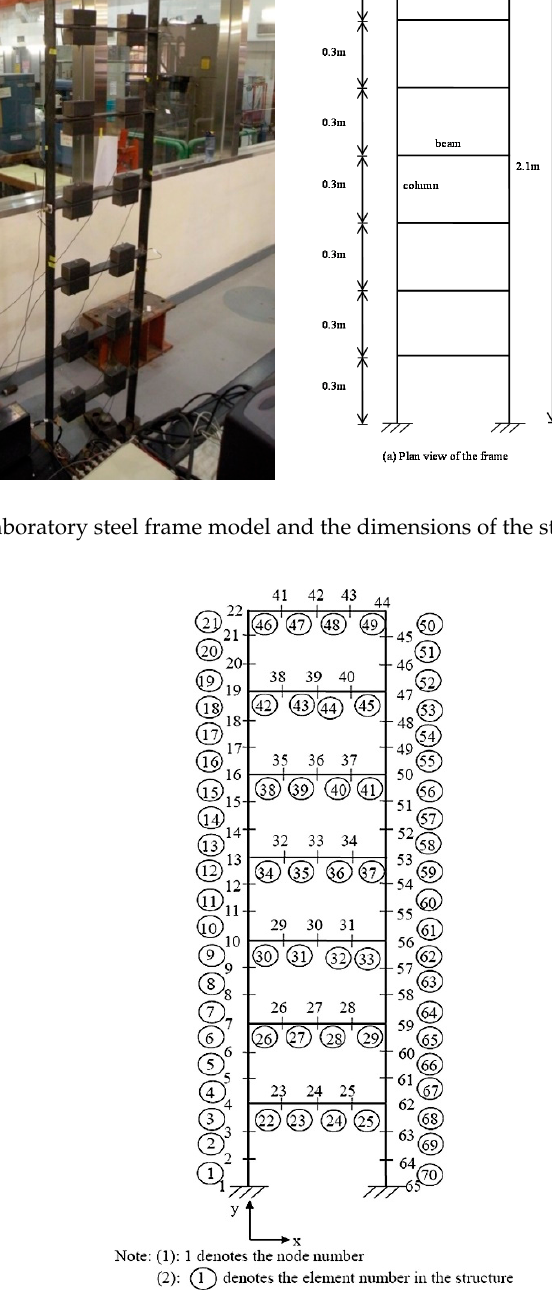
Figure 4. Finite element model of the steel frame structure.